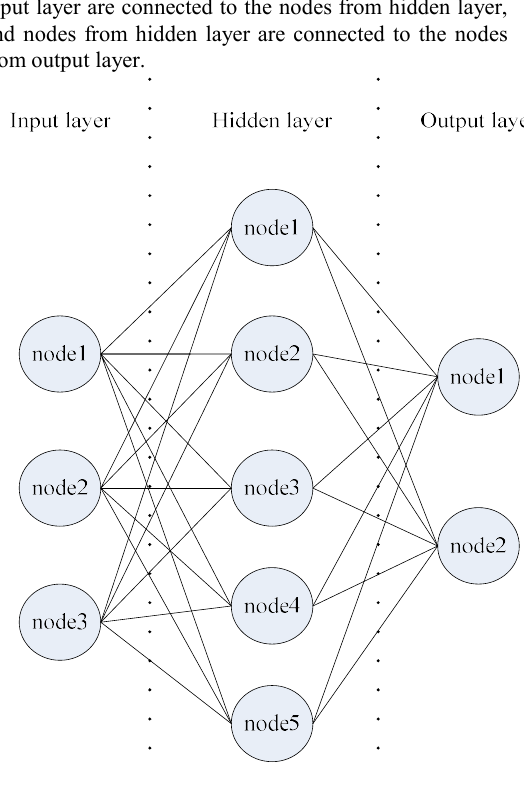
Figure 1. A BP neural network